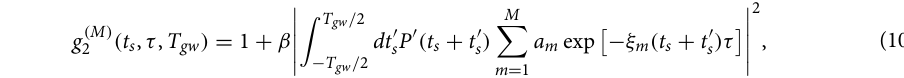
where T gw is the gate width, and P ′ ( t s ) is the normalized measured photon distribution of time-of-flight (DTOF), which is related to the true photon TOF distribution P ( t s ) via a convolution ( ⋆ ) with the IRF, I 0 ( t s ) :